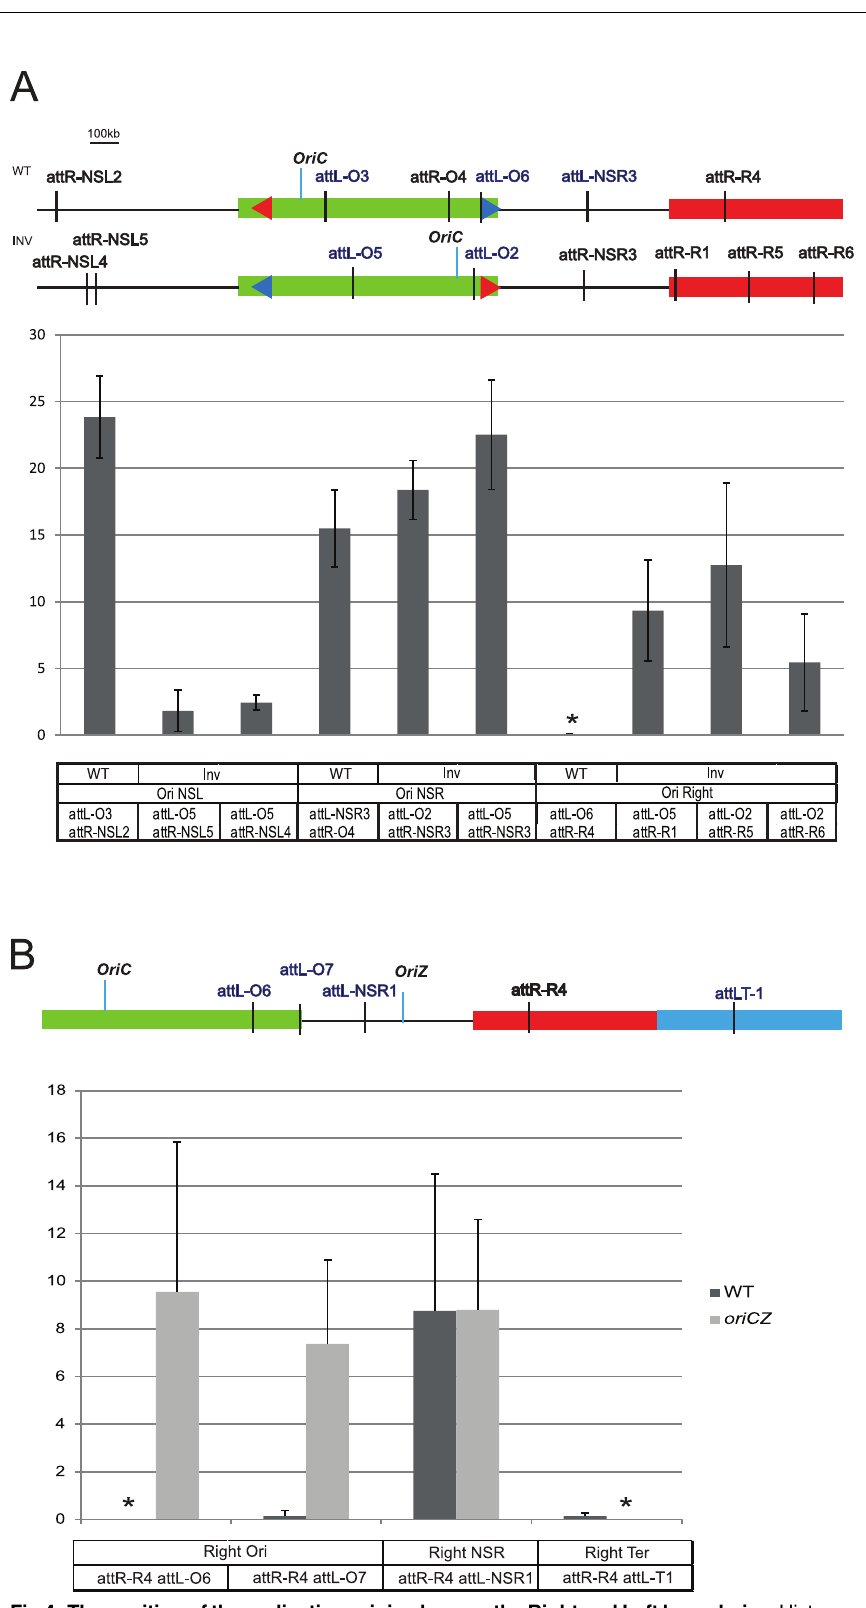
Fig 4. The position of the replication origin changes the Right and Left boundaries. Histograms of recombination frequencies between att L and att R sequencesin WT, and Inv strain.